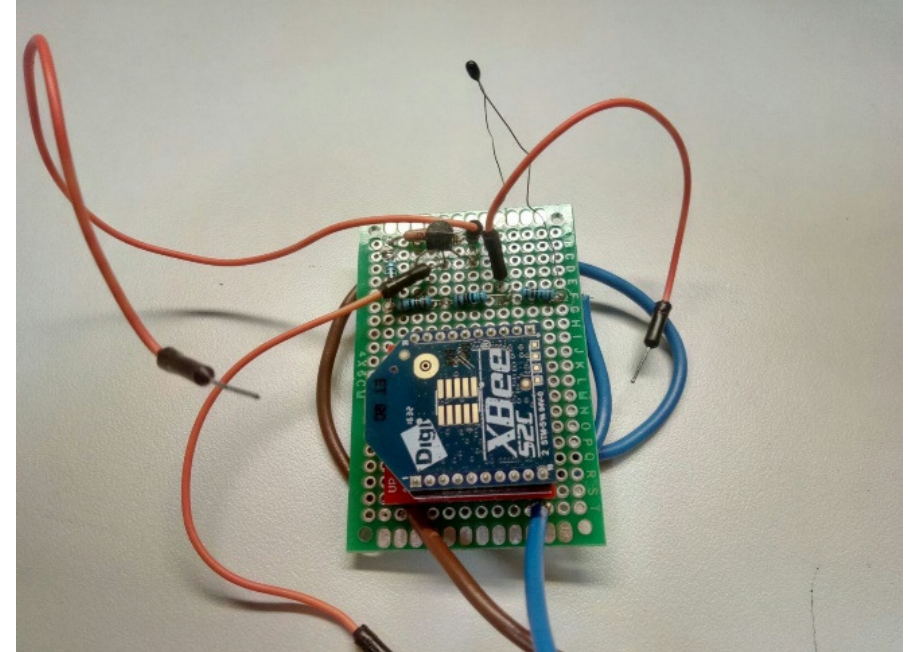
Figure 8. The first prototype of a sensor node made in a pre-drilled board. Three inputs were used: one with a PR103J2 sensor, one with an LMT84 sensor and another with a voltage divider to validate the values of the